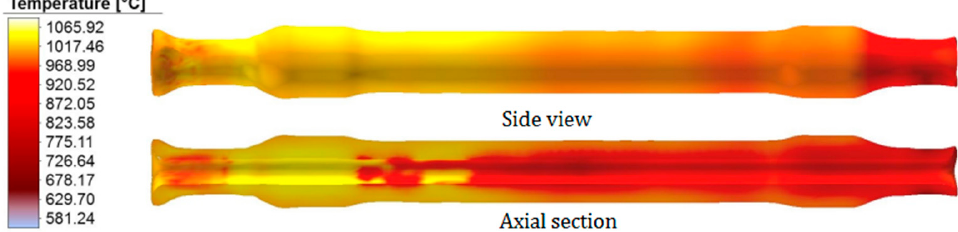
Figure 31. Distribution of temperature in hollow axle [37] (Reprinted from ref. [37]).